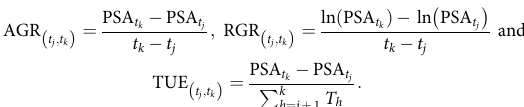
(Supplementary Table 6). We used two GWAS approaches: one considers the response for each salt treatment in a separate model, and the other, referred to as the interaction model, amalgamates each response for both treatments. Both approaches use an MLM that is fitted to include the kinship ( K ) matrix as a random effect to control for population structure 50,51 . When analysing the combined population INDAUS , we also included principal components to control for population structure, because of the deep population structure in rice 21,23 . Thus, the difference between the two approaches is the ability to examine the interaction effects between the SNP markers and the salt treatment, which is included as a cofactor in the interaction model. Analyses of the first approach were conducted using TASSEL software (http://www.maizegenetics.net/tassel) 52 ; analyses of the second approach, the new MLM referred to as interaction model, was fitted using the ASReml-R 47 , a package for the R computing environment 44 , according to the following equation: